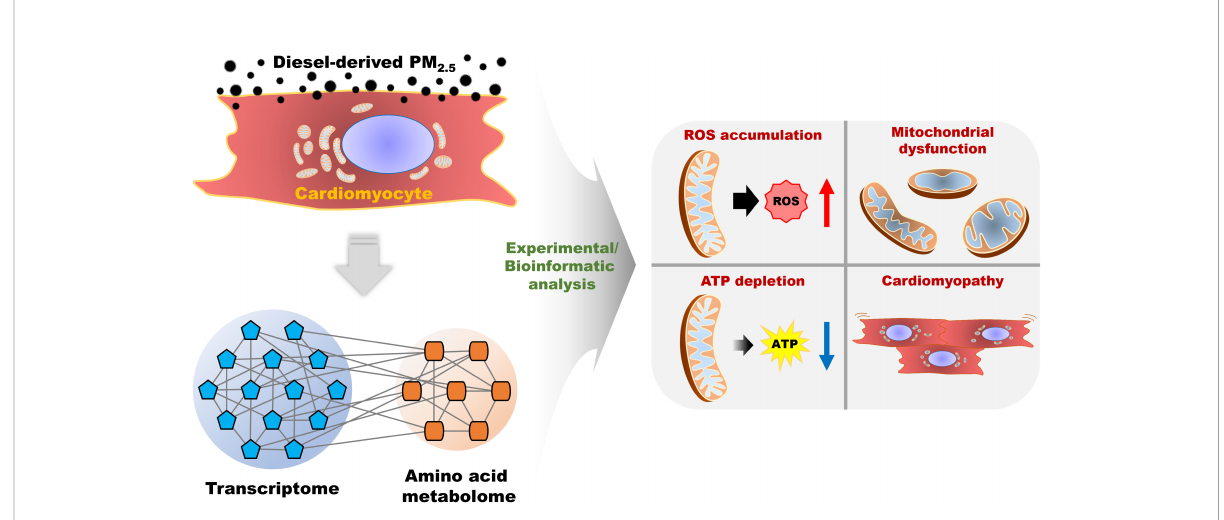
FIGURE 8 The summarized scheme of overall analysis for diesel-derived PM 2.5 exposure in HL-1 mouse cardiomyocyte cell line.